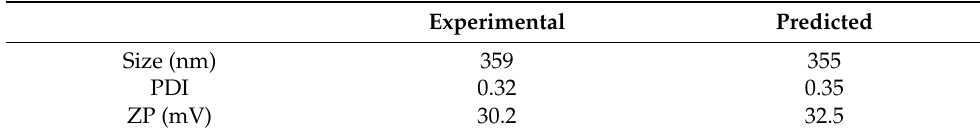
Figure 2. The Particle size and zeta potential (ZP) distribution of produced chitosan nanoparticles (CSNPs) by using 3 mg/mL of CS, 1 mg/mL of STPP, and a CS to STPP ratio of 3:1. Table 3. Experimental validation data of the optimal